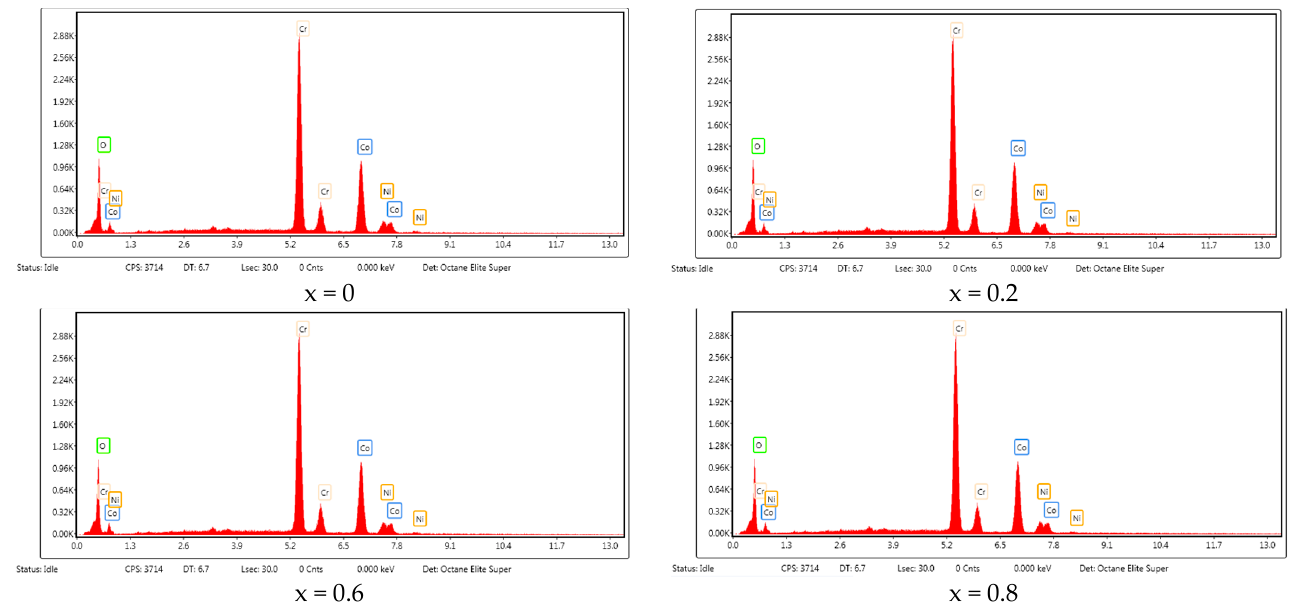
Figure 5. EDS results of Co 1 − x Ni x Cr 2 O 4 (x = 0.2, 0.4, 0.6, 0.8).